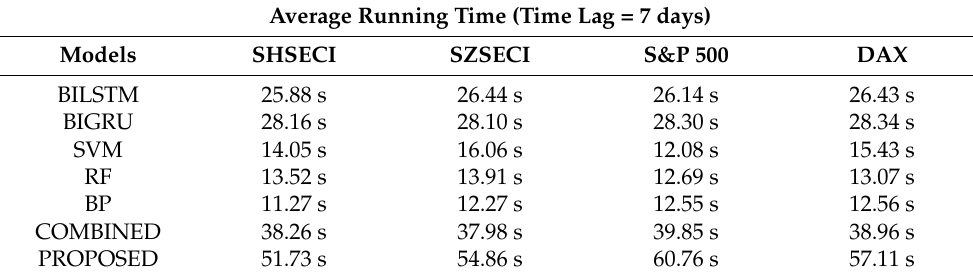
Table 4. Comparison of running time of 7-day lag experiments.